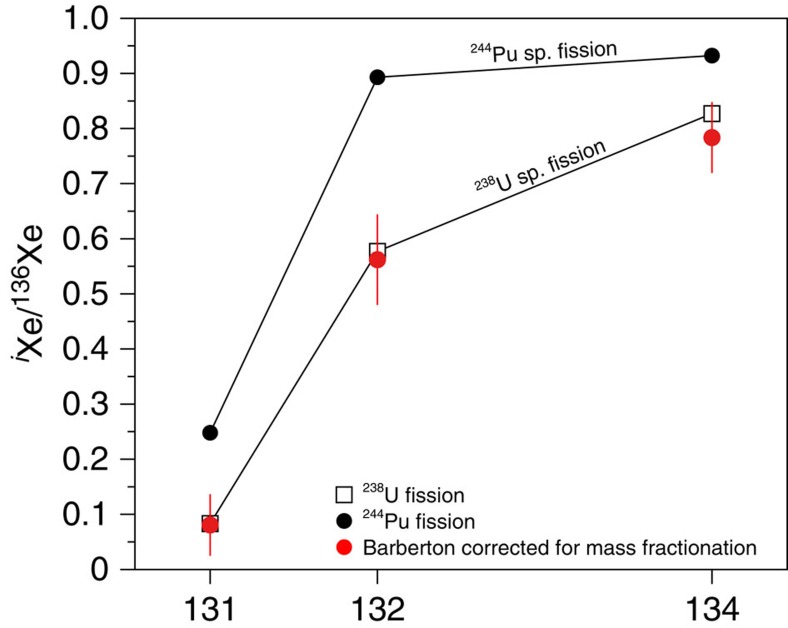
Fission spectrum of Barberton Xe corrected for mass-fractionation relative to a starting isotopic composition similar to U-Xe.It corresponds to spontaneous fission of 238U. The fission spectra for fission of 238U and 244Pu are from a compilation in ref. 56. Errors at 2σ.